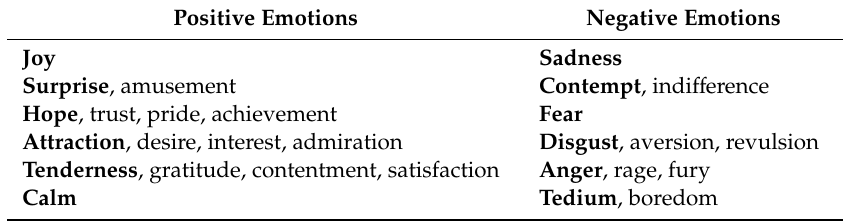
Table 1. Emotion classification considered in this work for the search of audiovisual stimuli and their subsequent labelling.